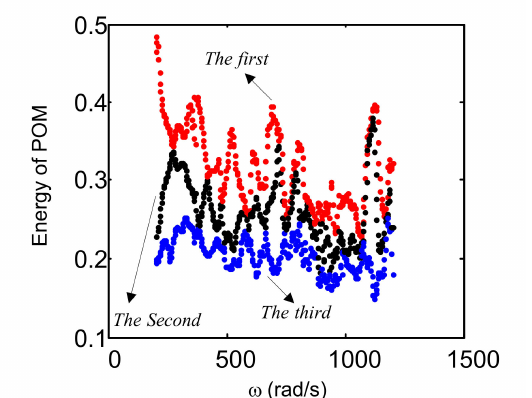
Figure 22. The POM (proper orthogonal mode) energy of the 24-DOFs (degrees of freedom) model with coupling